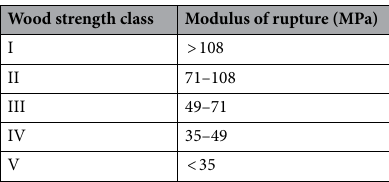
Table 3. Strength classification of Indonesian wood with bending strength 27